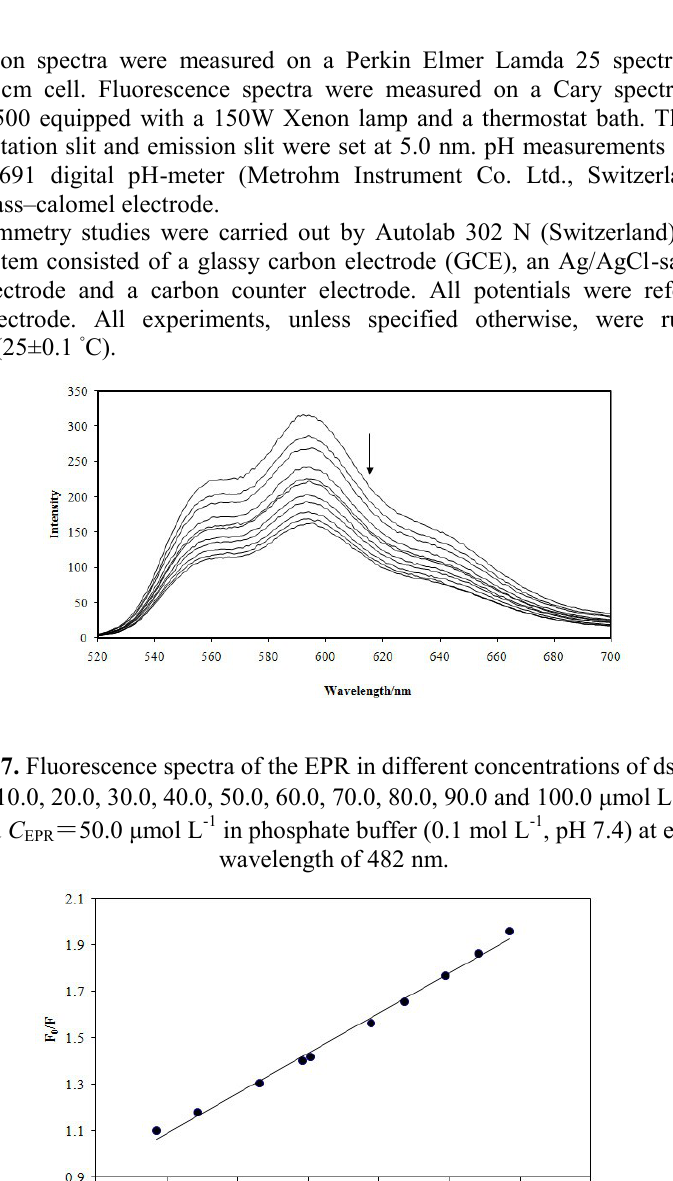
Figure 8. Stern-Volmer plot for the interaction of EPR with DNA. C phosphate buffer (0.1 mol L -1 , pH 7.4) at excitation wavelength of 482